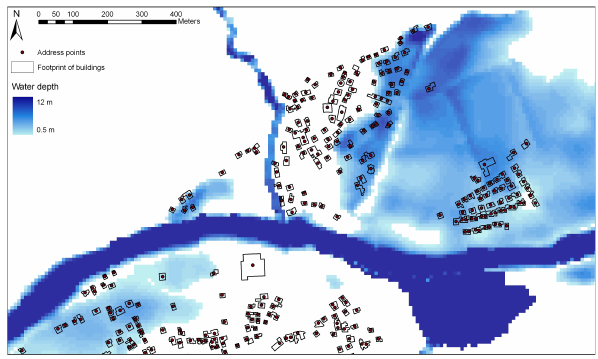
Fig. 9. Exemplary visualisation of the interaction between the water depth, resulting from the hazard analysis, and the stock of elements and values to identify the elements at risk, the damage potential, and to enable the evaluation of the ESL. The address points are linked to the